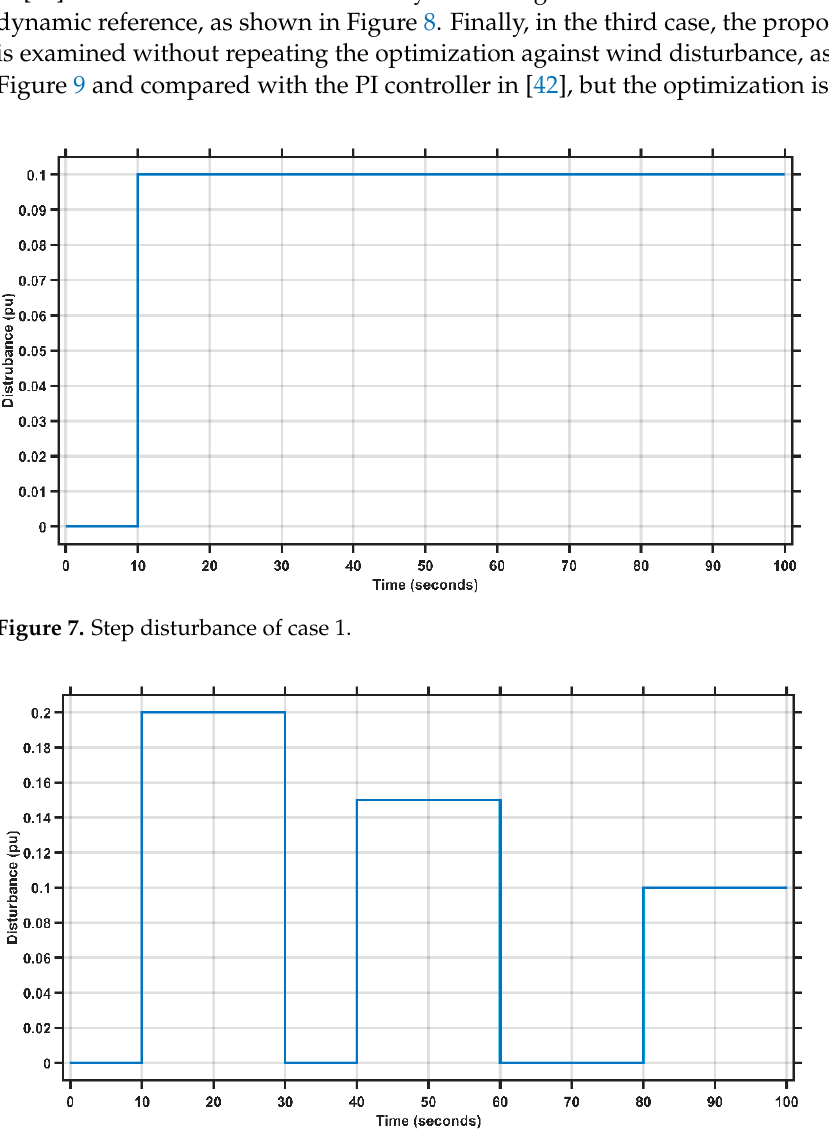
Figure 8. Dynamic disturbance of case 1.